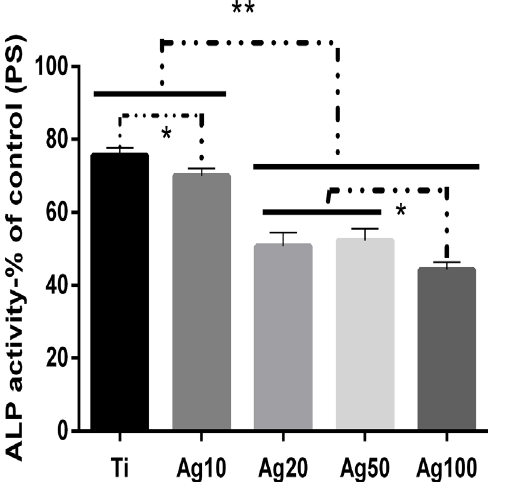
Fig 10. ALP activity of MC3T3 on the specimens after incubation for 7 days. The data are expressed as means ± standard deviations (n = 3). One-way ANOVA followed by SNK post hoc test is utilized to determine the level of significance. * p < 0.05 and ** p <